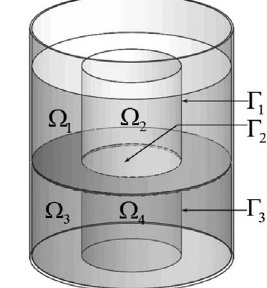
Fig. 1. Container and baf fl e. Fig. 2. Sub-domains and